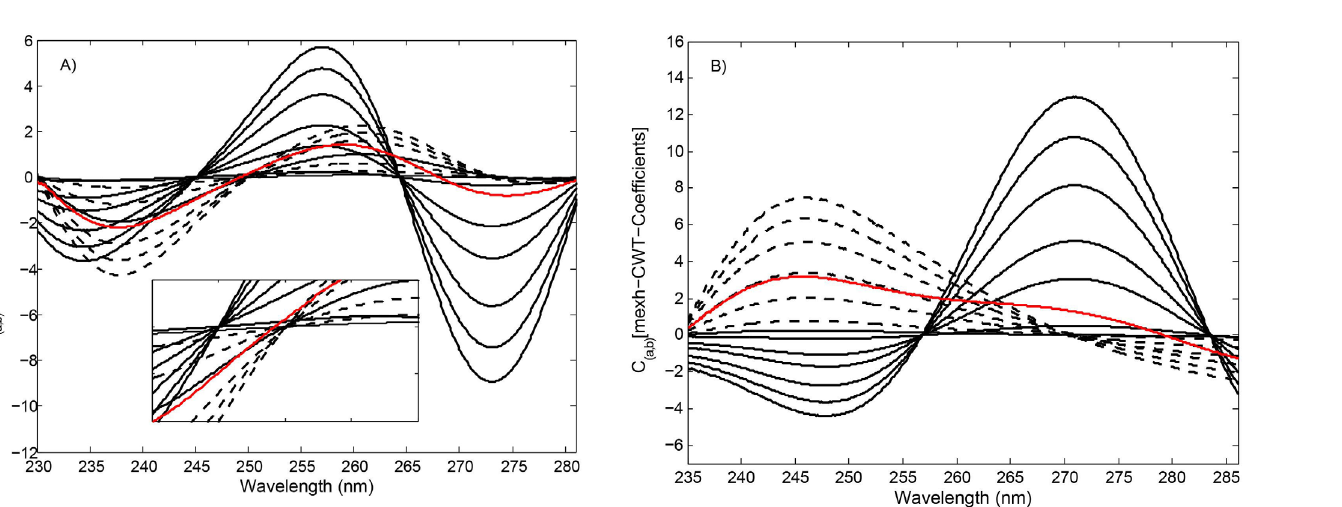
FIGURE 2B - mexh-CWT spectra of VAL (----) : 1.0, 3.0, 9.0, 15.0, 21.0, 27.0, 33.0 µ g/mL and HCT (  ) : 1.0, 6.0, 11.0, 16.0, 21.0, 26.0 µ g/mL and tablet sample (  ) containing 2.50 µ g/mL of VAL and 16.0 µ g/mL of HCT .